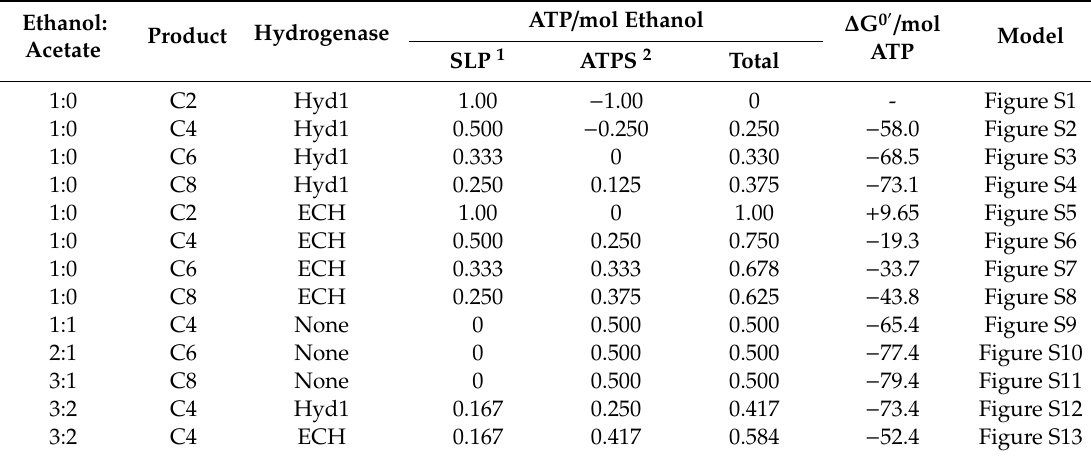
Table 4. Predicted ATP production and free energy release for the conversion of ethanol to acetate, butyrate, hexanoate, and octanoate with either a ferredoxin hydrogenase (Hyd1) or energy-conserving hydrogenase (ECH).